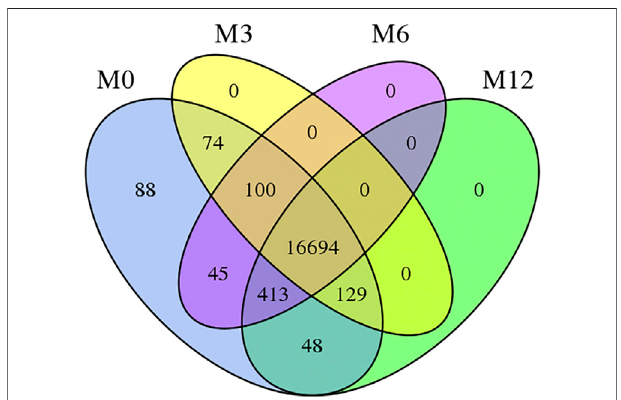
FIGURE1 | Venn diagram offour development stages expressed genes Note: M0 represents 0-month-old, M3 represents 3-month-old, M6 represents 6-month-old, M12 represents 12-month-old.